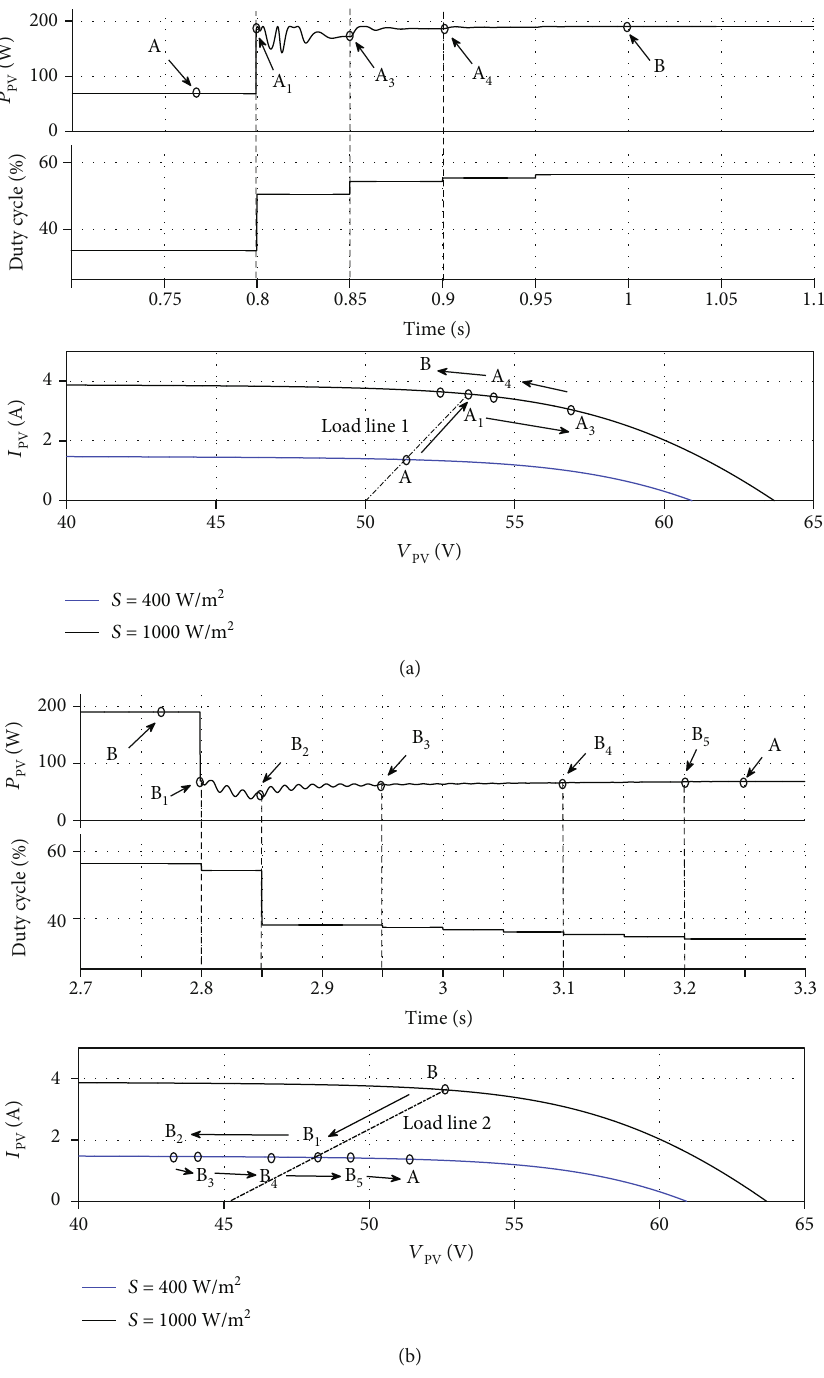
Figure 9: Simulation results by using the proposed technique: (a) power, duty cycle, and tracking process when the irradiance is increased; (b) power, duty cycle, and tracking process when the irradiance is